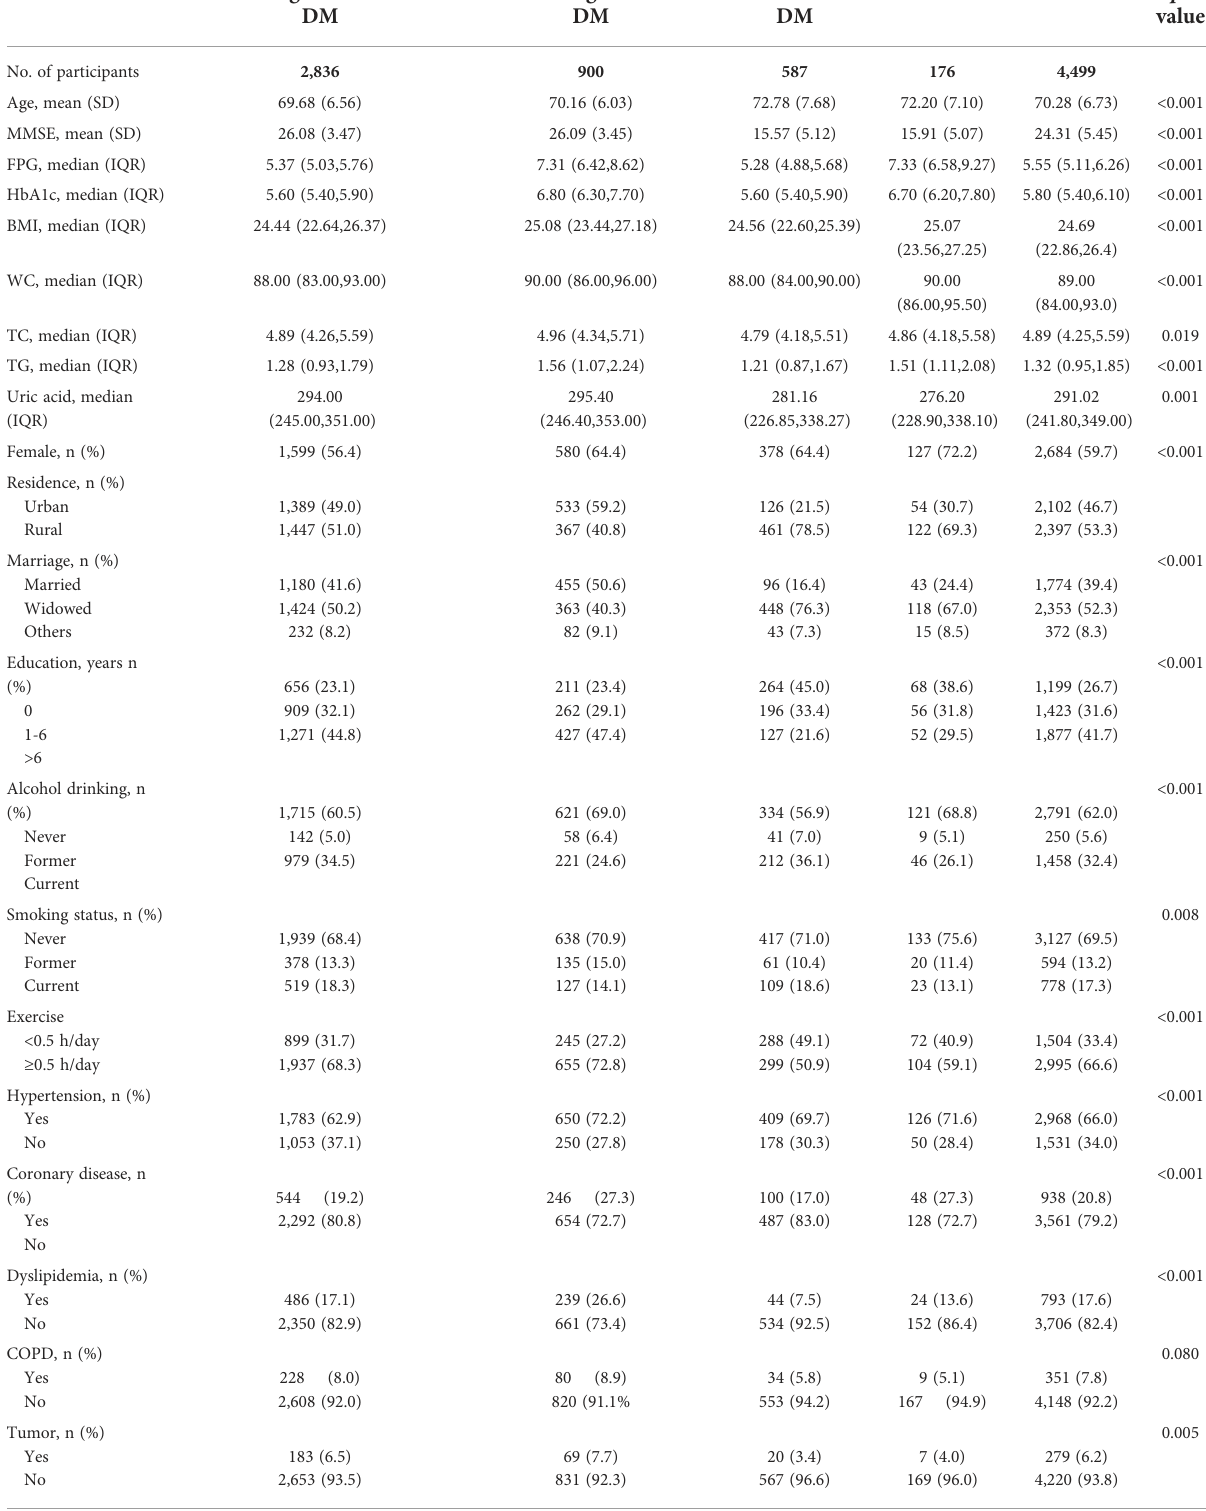
TABLE 1 Baseline characteristics of participants by diabetes and cognition